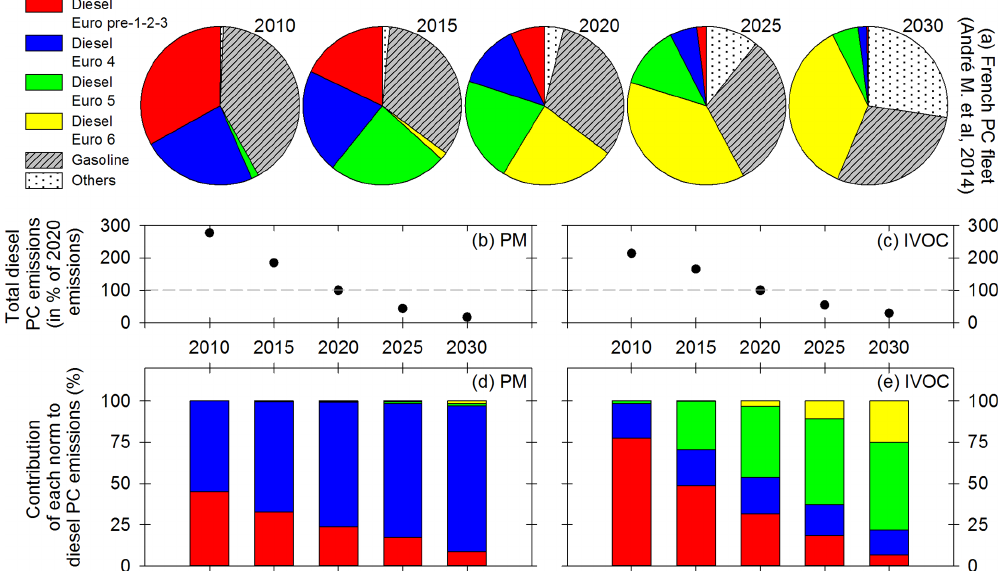
Figure 7. Evolution of the French passenger car fleet (a) given by André et al. (2014) for diesel vehicles of norm Euro pre-1-2-3 (red), Euro 4 (blue), Euro 5 (green) and Euro 6 (yellow) as well as gasoline vehicles (hatched grey) and vehicles with other motorizations like hybrid or electrical (dotted white). Total emissions of PM (b) and IVOCs (c) by diesel PCs given as a percentage of the 2020 emissions. Contribution of each Euro norm to diesel PC emissions of PM (d) and IVOCs (e) . Results are given for the years 2010, 2015, 2020, 2025 and 2030.